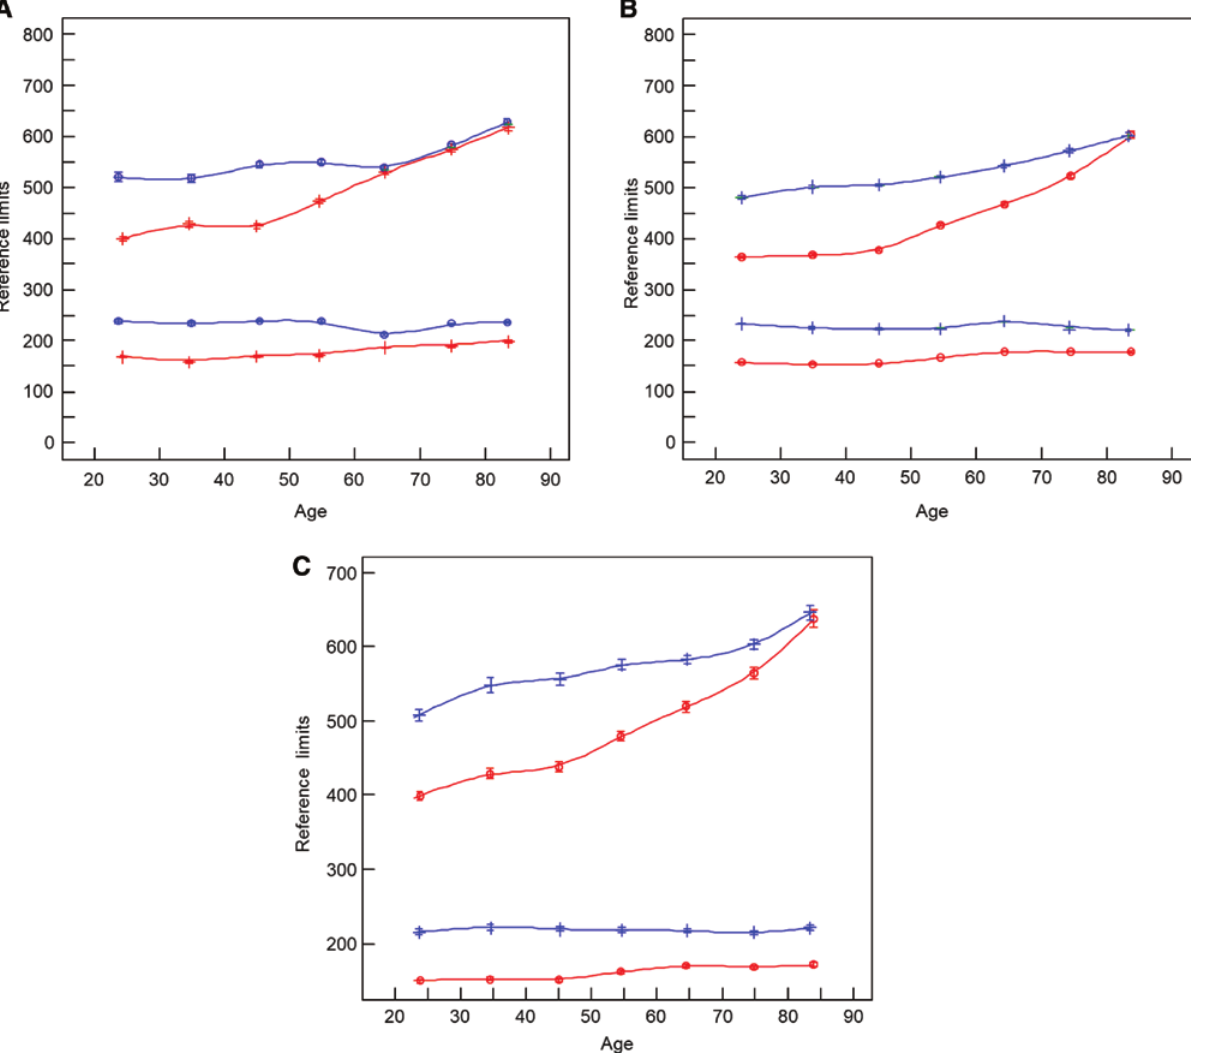
Figure 1: Reference limits of serum uric acid ( μ mol/L) depending on age (years) separated by sex. Lower lines represent the 2.5 th percentile, upper lines the 97.5 th percentile, blue lines represent men (n = 24,582) and red lines women (n = 24,579). The data were obtained from primary health care laboratories without exclusion of data (A: laboratory 1, n = 339,192; B: laboratory 2, n = 615,290), and from a university hospital (a mixture of hospitalised patients and outpatients; C: laboratory 3, n = 330,589).